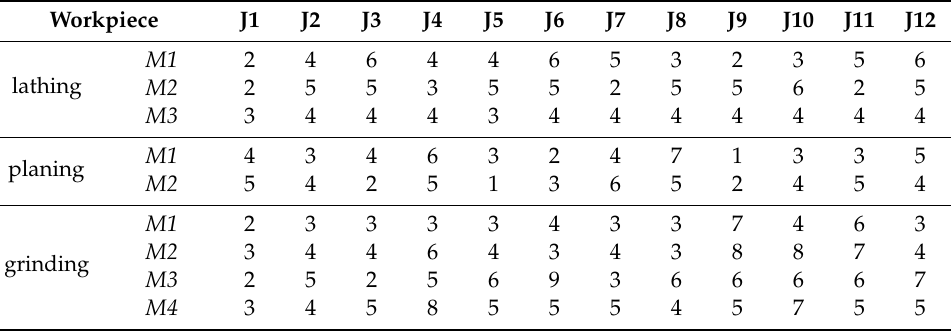
Table 1. Processing time of each workpiece on each